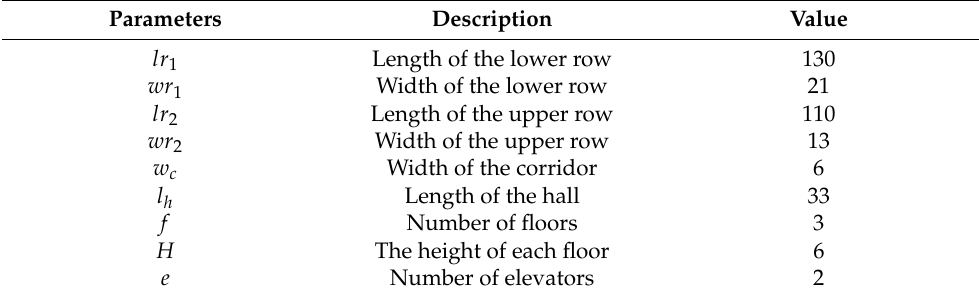
Table 3. Parameters of the